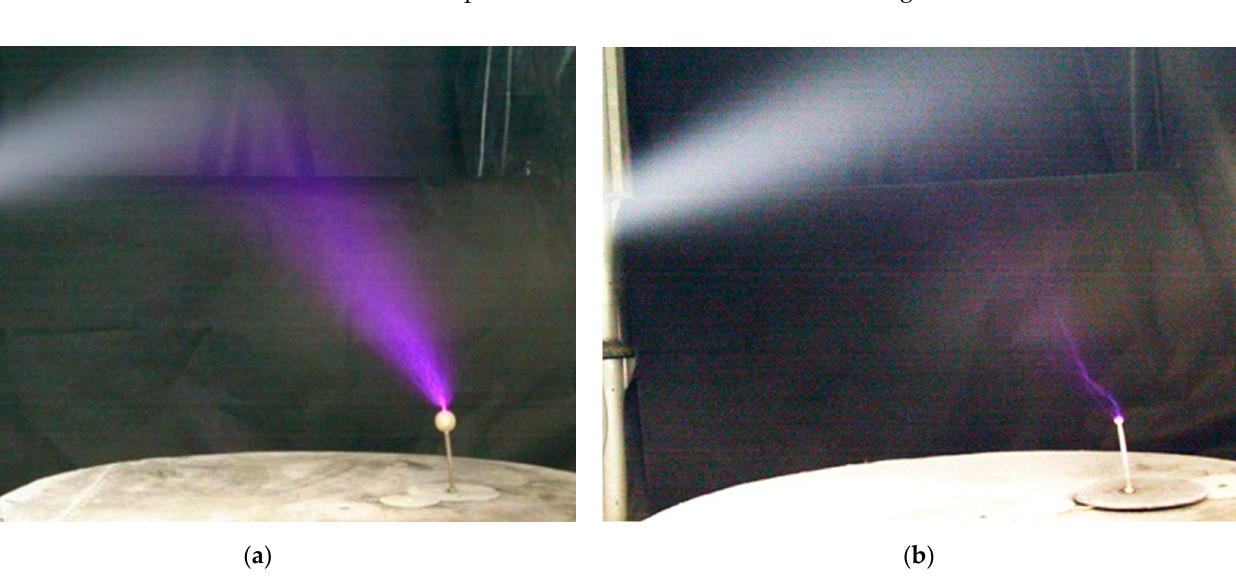
Figure 2. Pulse streamer corona flash ( a ) without upward leader transition and ( b ) transitioning into an upward leader.